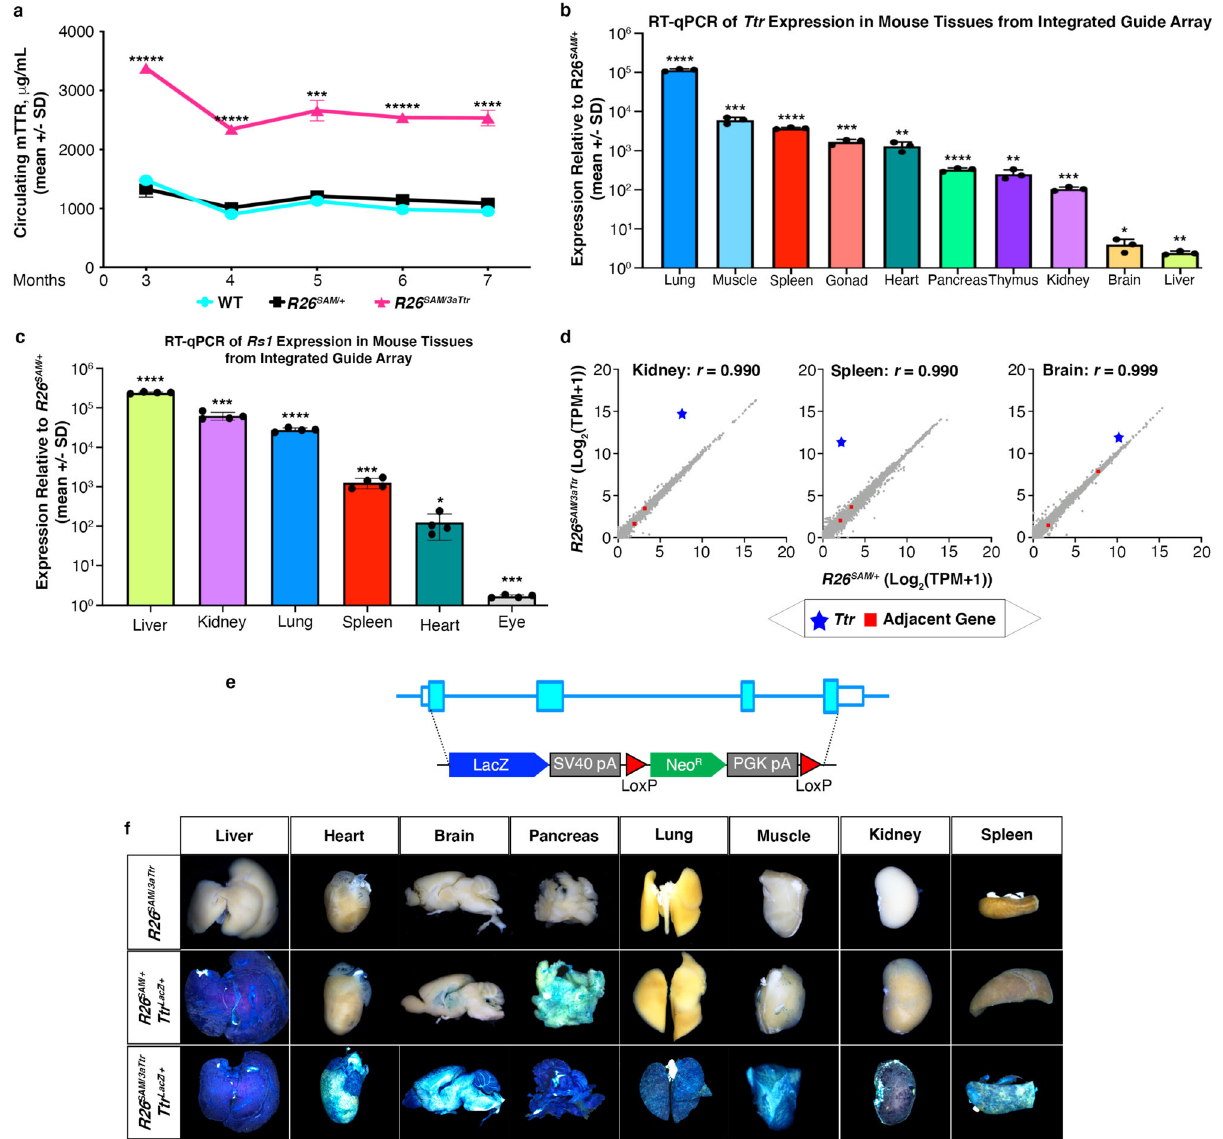
Fig. 2 Validation of R26 SAM in mice. a Mouse serum TTR levels were evaluated in R26 SAM / 3aTtr ( n = 7), R26 SAM / + ( n = 4) and WT ( n = 4) for 7 months with monthly bleeds starting at 3 months. ELISA was used to determine protein levels in each mouse and values were plotted as the mean per group + / − SD. Monthly p -values can be found in Supplemental Table 2. Two independent replicates were conducted. b RT-qPCR determination of Ttr expression levels per tissue in R26 SAM / 3aTtr mice ( n = 3) relative to R26 SAM / + plotted as the mean per group + / − SD. p -values of each tissue can be found in Supplemental Table 2. c RT-qPCR analysis of Rs1 expression in R26 SAM / 3aRs1 mouse tissues ( n = 4 mice per tissue) plotted as the mean per group + / − SD. p -values of each tissue can be found in Supplemental Table 2. d RNA-seq characterization of R26 SAM / 3aTtr mouse tissues versus the parental R26 SAM/ + line. The transcriptome of each mouse tissue from fi ve mice were sequenced to determine the number of target-speci fi c TPM. The target gene is noted with a blue star and the adjacent genes with red squares. Kidney: r = 0.990, Spleen: r = 0.990, Brain: r = 0.999. e Schematic of LacZ knockout approach. The Ttr mouse coding sequence was replaced in mESCs starting at ATG with the LacZ coding sequence ( Ttr LacZ / + ). f Tissues harvested from R26 SAM / 3aTtr ; R26 SAM / + mice ( n = 3), R26 SAM / + ; Ttr LacZ / + mice ( n = 3) and R26 SAM / 3aTtr ; Ttr LacZ / + mice ( n = 3) stained with X-gal. Statistics: Asterisks (*) indicates signi fi cance, and the number of asterisks (*) indicates the number of 0s after the decimal point. One-tailed, unpaired Student ’ s t -test for ( a – c ) and Pearson ’ s correlation for ( d